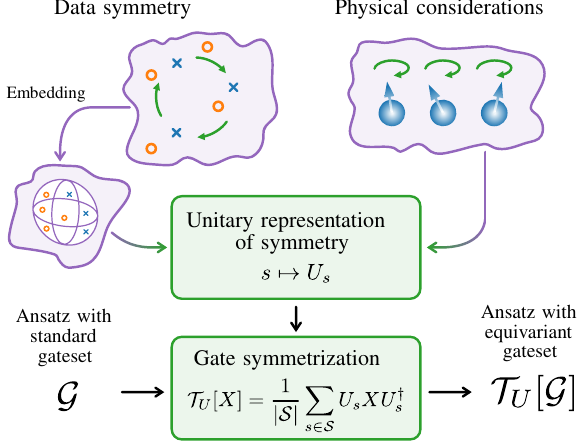
FIG. 1. A unitary representation of a symmetry group S can arise from data symmetries when the data points are suitably encoded or alternatively from physical considerations of a vari- ational problem. We can use such a representation to replace gates with their equivariant counterparts and thus symmetrize generic ansätze used in the construction of learning models and variational